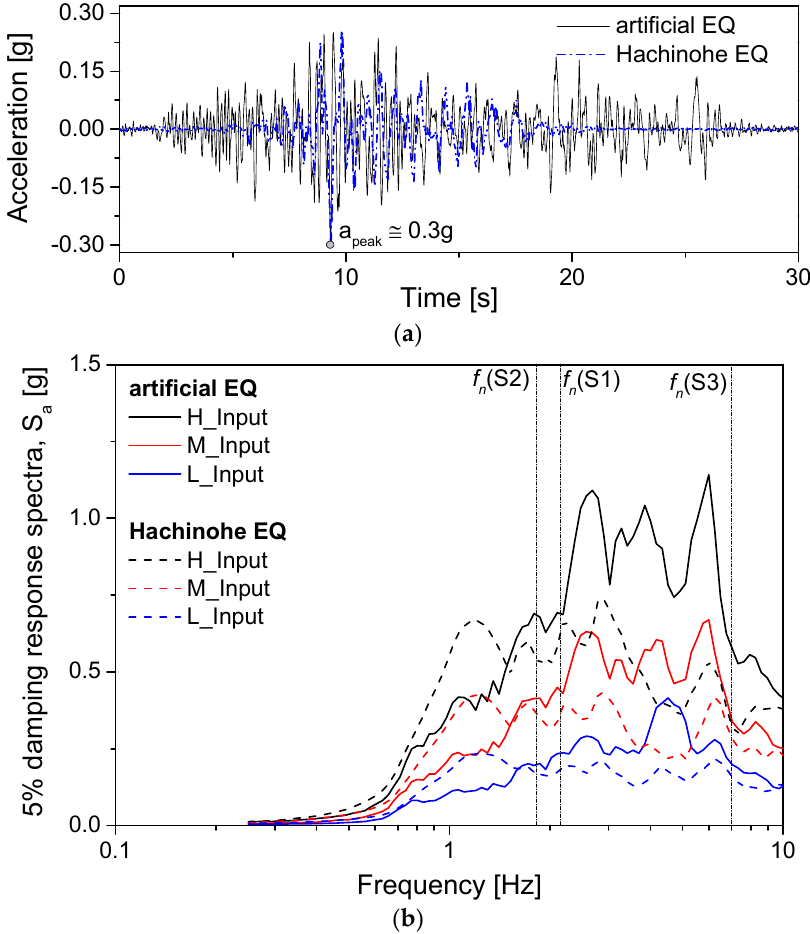
Figure 3. Input motions in time domain ( a ) and 5 % damping response spectra ( b ). f n denotes fixed-base frequency of each building.